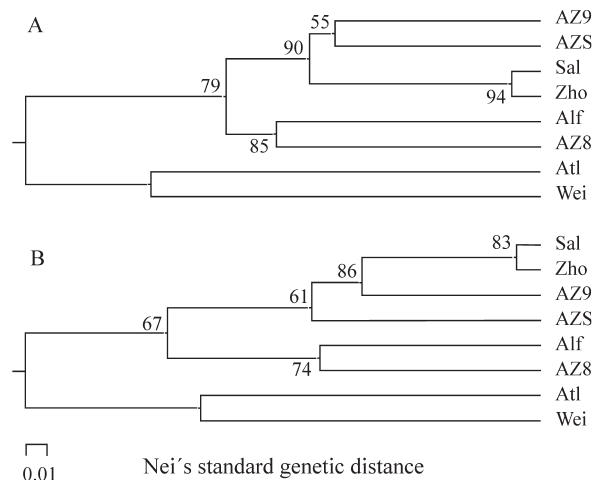
Figure 4 - Unweighted pair group-method with arithmetic mean (UPGMA) dendrogram of eight autotetraploid alfalfa accessions based on Nei’sstandardgeneticdistance.FigureAshowstheresultsfortheconven- tional binary method and Figure B those for our novel autotetraploid sta- tistical method. The numbers at nodes are the percent occurrence in 1,000 bootstrap replicates. See Figure 2 for the